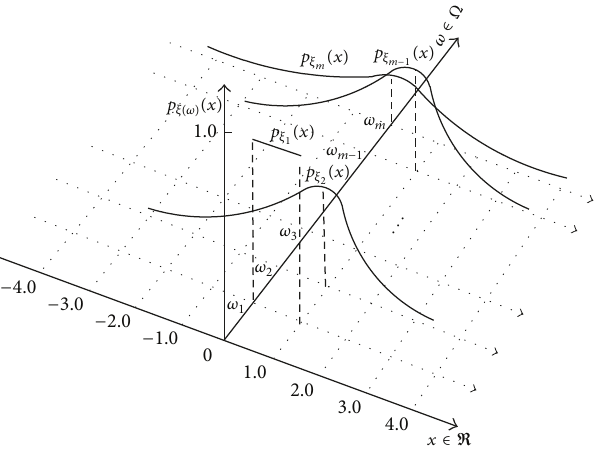
Figure 1: A birandom